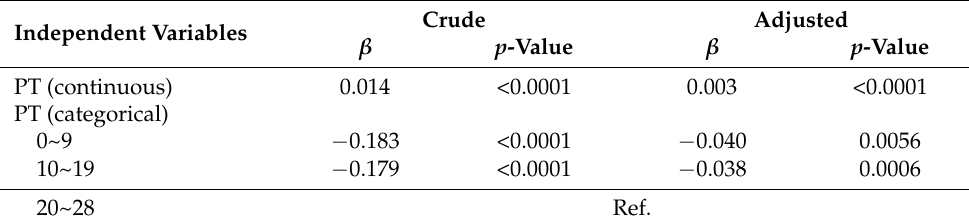
Table 2. Multivariate regression analysis for PT and relative handgrip